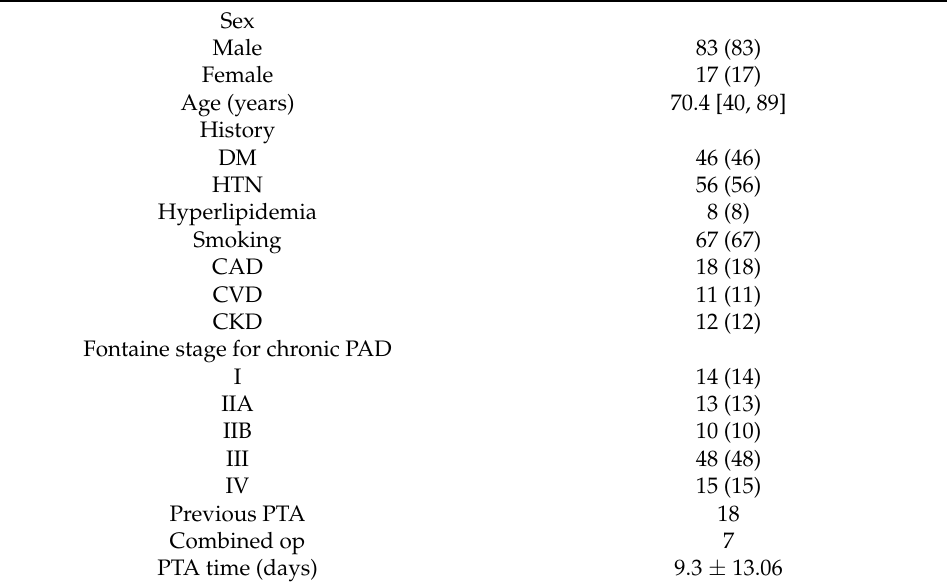
Figure 1. Patient selection flowchart. Table 1. Patient demographics ( n = 100).